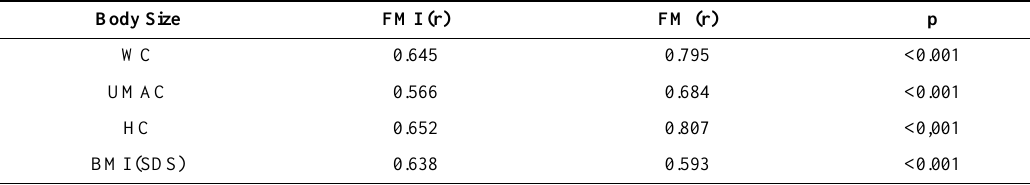
Table 4. Correlation coefficients of indirect measurement methods and BIA